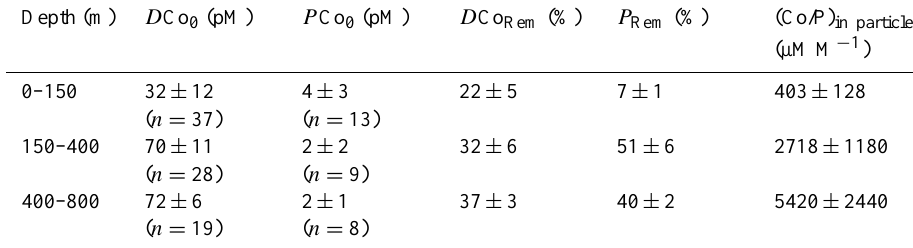
Table 3. Mean dissolved cobalt concentration ( D Co;pM), mean apparent particulate cobalt concentration ( P Co;pM), and percentages of dissolved cobalt and phosphate produced by cumulative remineralization (respectively D Co rem and P rem ; %) calculated in the surface layer (0–150m), the upper layer of Atlantic Central Waters (150–400m) and the lower layer of Atlantic Central Waters (400–800m) between 10 ◦ S and 10 ◦ N (see text for definitions and calculation). The particulate ratios of Co:P ((Co/P) in particles ; µMM − 1 ) recorded in the western Atlantic (Sherrell and Boyle, 1992) are also indicated for comparison. Errors are given as standard deviation from averaged values. Depth (m) D Co 0 (pM) P Co 0 (pM) D Co Rem (%) P Rem (%) (Co/P) in particles (µMM − 1